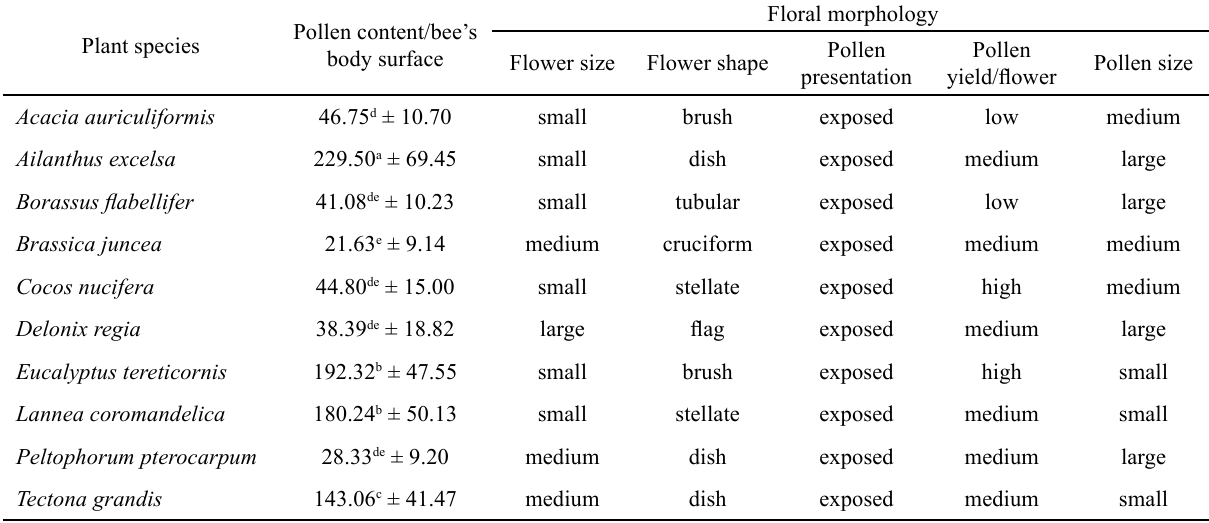
Table 5. Pollen presentation (on bee’s body surface) of some nectariferous plants and their floral